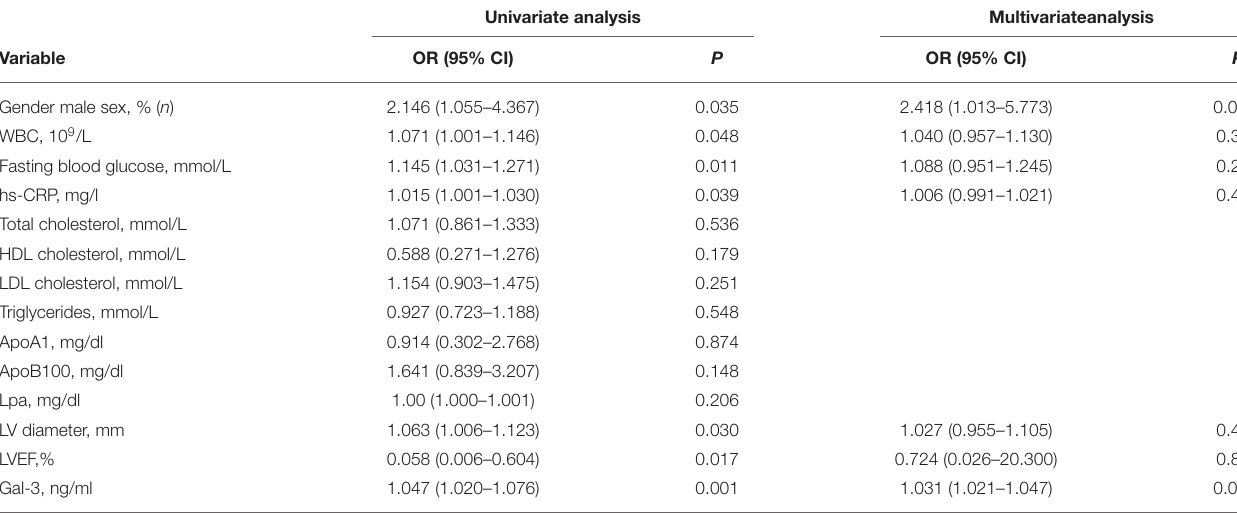
TABLE 6 | Univariate and multivaiate logistic regression analysis for risk factors attributing to high SS (SS > 22) in the CAD patient. Univariate analysis Multivariateanalysis